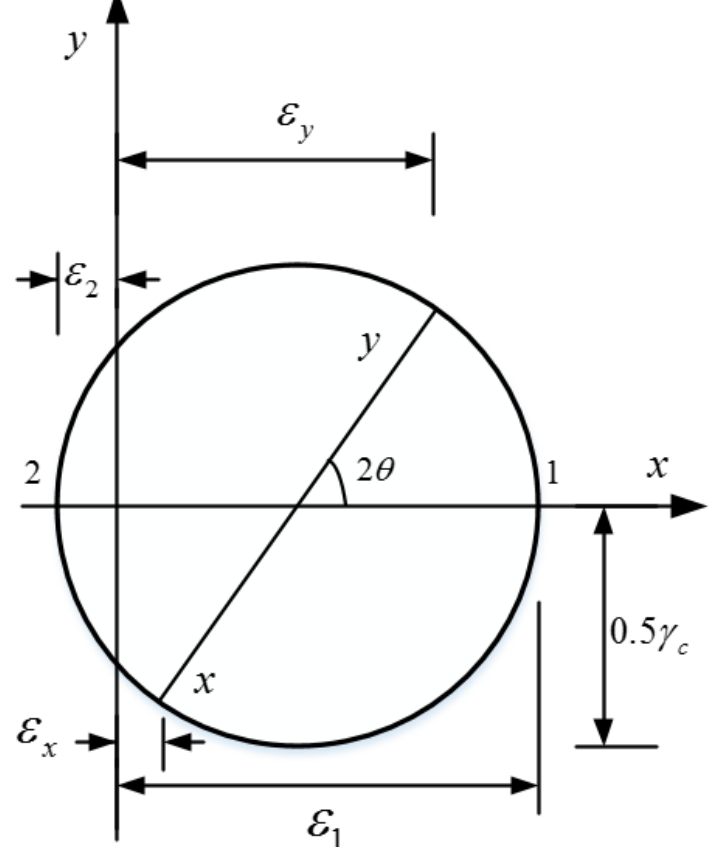
Figure 5. Strain of cracked concrete element.